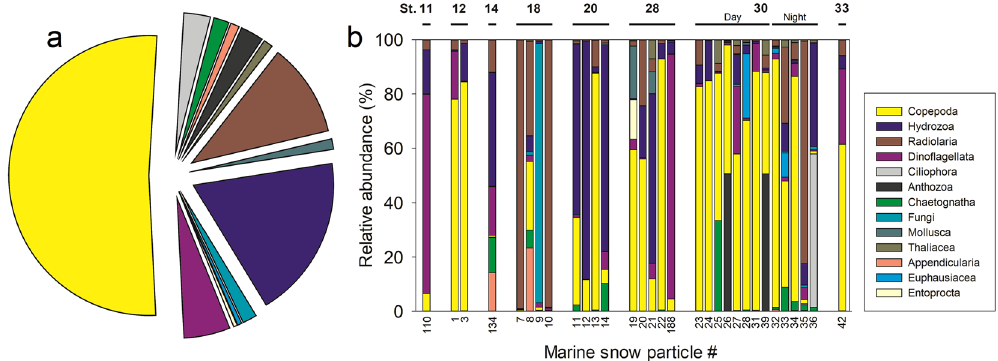
Figure 4. Marine snow composition based on 18S rRNA gene sequencing. ( a ) The average composition of 31 marine snow particles. ( b ) Composition of individual marine snow particles. For detailed information on specific particle numbers see Table S4. Particles are sorted by transects and stations. Note that station 30 is divided into day and one night